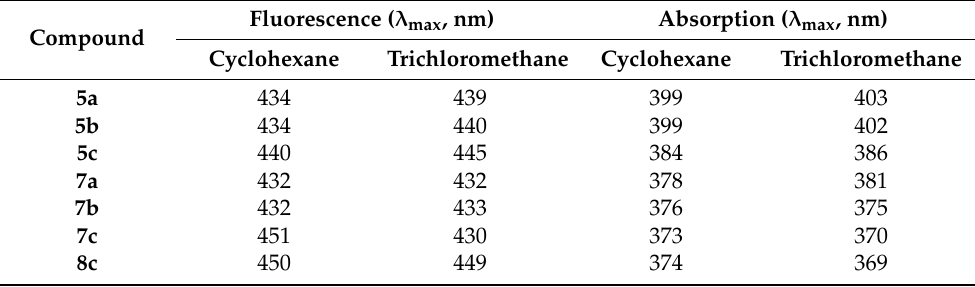
Table 2. λ max (nm) of absorption spectra and λ max (nm) of emission spectra of compounds 5a – c , 7a – c , and 8c . Fluorescence ( λ max , Compound